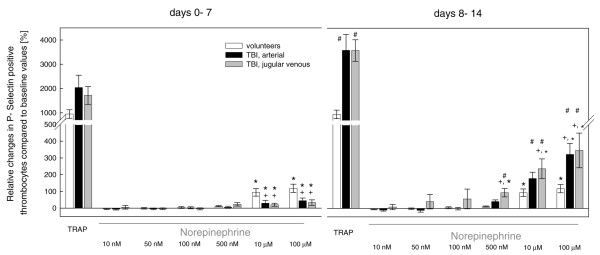
Relative increases in norepinephrine-induced expression of P-selectin in arterial (black bars) and jugular venous (grey bars) platelets isolated from severe traumatic brain injury (TBI) patients and peripheral venous platelets taken from healthy controls (white bars) expressed as a percentage of baseline values. Baseline values were determined in platelets not stimulated in vitro with norepinephrine. During the first week, the norepinephrine-mediated increase in P-selectin-positive platelets was significantly reduced compared with controls. In the second week, the norepinephrine-mediated increase in P-selectin expression significantly exceeded changes seen in the first week and in healthy volunteers. Overall, there was no significant difference between arterial and jugular venous platelets. During the second week, the TRAP-mediated increase in P-selectin-positive platelets significantly exceeded the TRAP-induced activation observed during the first week. #P <0.001 second week versus first week; +P <0.01 patients versus controls; * P <0.01 norepinephrine of greater than 500 nM versus norepinephrine of less than 10 μM. TRAP, thrombin receptor-activating peptide.